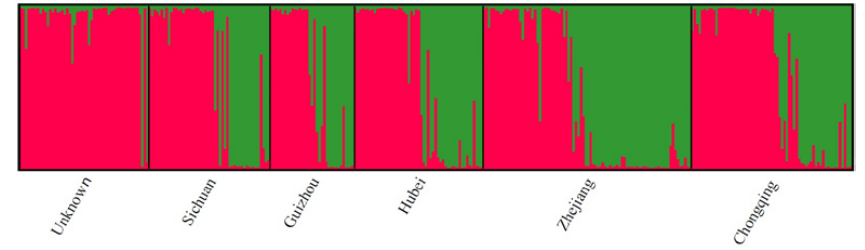
Figure 4. Assignment of 343 breeding parents to two populations using Structure version 2.0.